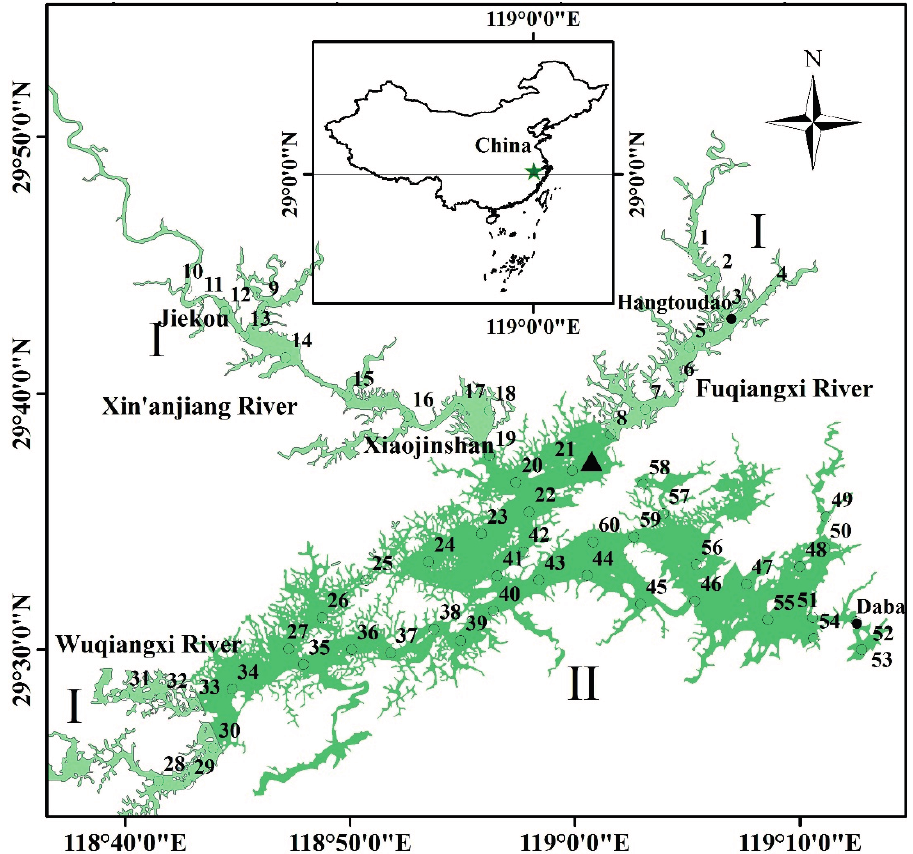
Figure 1. Location of Qiandaohu in China and the locations of Chun’an meteorological station ( ▲ ) and the transparency observation sites from 1988 to 2013 showing the two data sources: ( ● ) from 1988–2013, the observation sites were located in one inlet (Hangtoudao), and the only outlet of the reservoir (Daba) was used for long-term specific observations; ( ○ ) in 2013 and 2014, the observation sites were evenly distributed around the reservoir in winter, spring and summer. The 60 sites were classified into two groups. Type I: located in the adjacent waters of the three incoming rivers, including sites 1–19 and 28–33. Type II: located in the main body of the reservoir, including sites 20–27 and